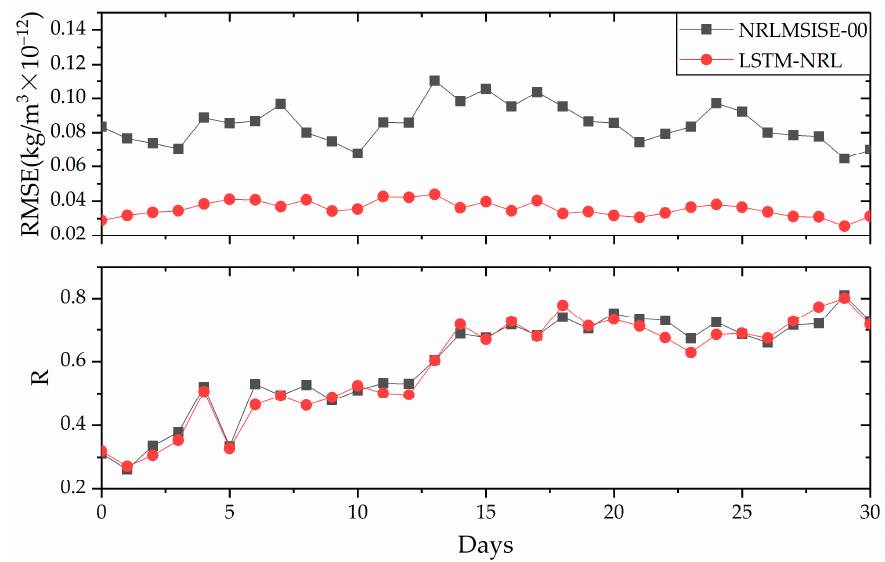
Figure 11. The daily RMSE and R values in January 2018, GRACE-B.